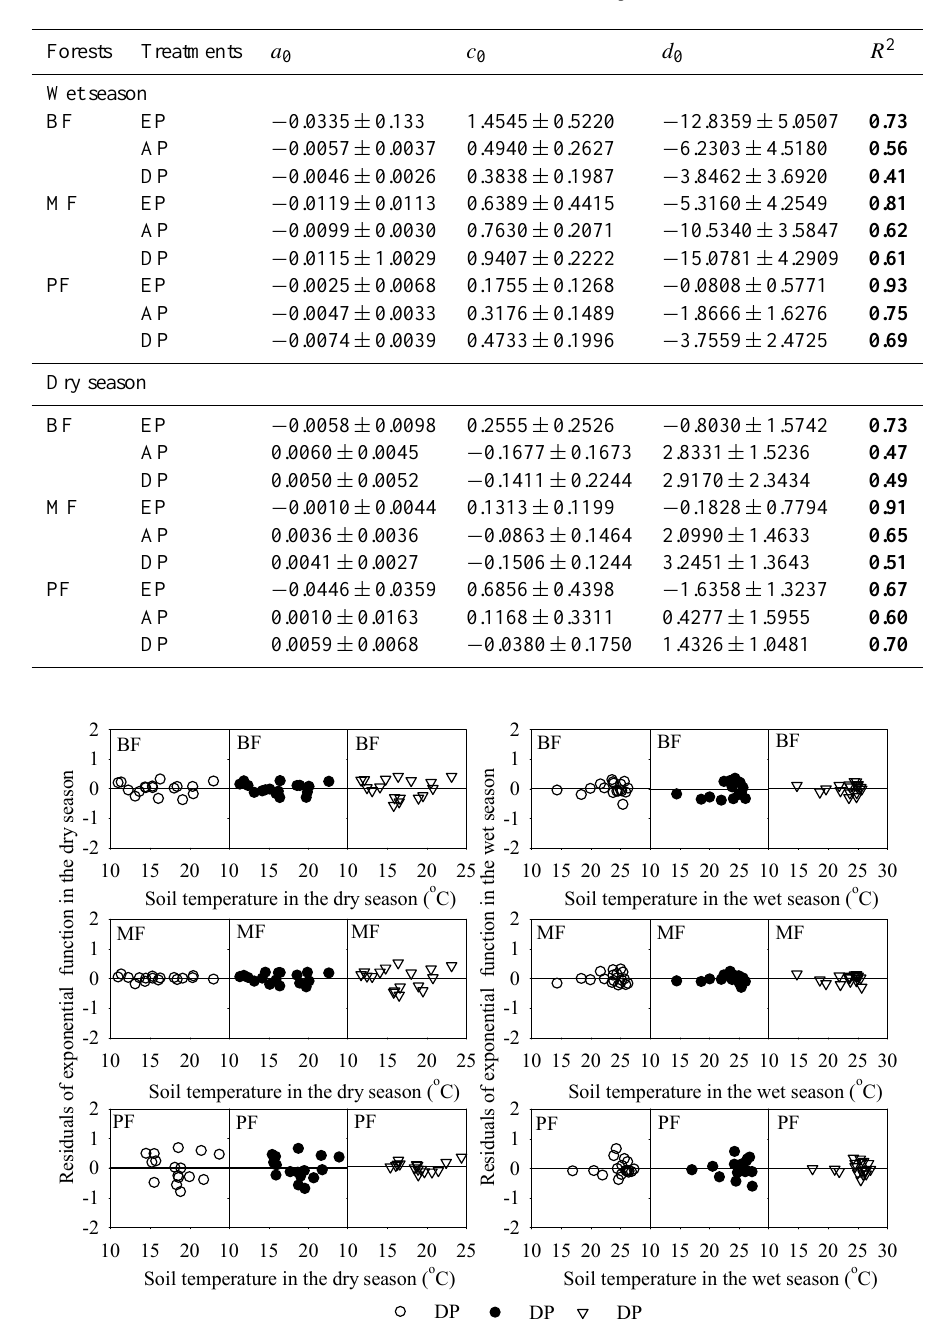
Table A3. Relationships of soil respiration (µmolCO 2 m − 2 s − 1 ) and soil moisture of the top 5cm soil layer (%vol.) using a quadratic function ( R = a 0 M 2 + c 0 M + d 0 , where R is soil respiration, M soil moisture, and a 0 , c 0 and d 0 are constants) (parameter estimate ± standard error) under different seasons and precipitation treatments at the DNR forests. The treatments are as follows: precipitation exclusion (EP), ambient precipitation (AP), and double precipitation (DP). The forests are as follows: broadleaf forest (BF), mixed forest (MF), and pine forest (PF). R 2 is the coefficient of determination. Numbers in bold indicate the level of function fitting is significant ( p < 0 . 05). Different superscripted letters in each forest site within a column denote significant difference ( p < 0 . 05) among precipitation treatments.